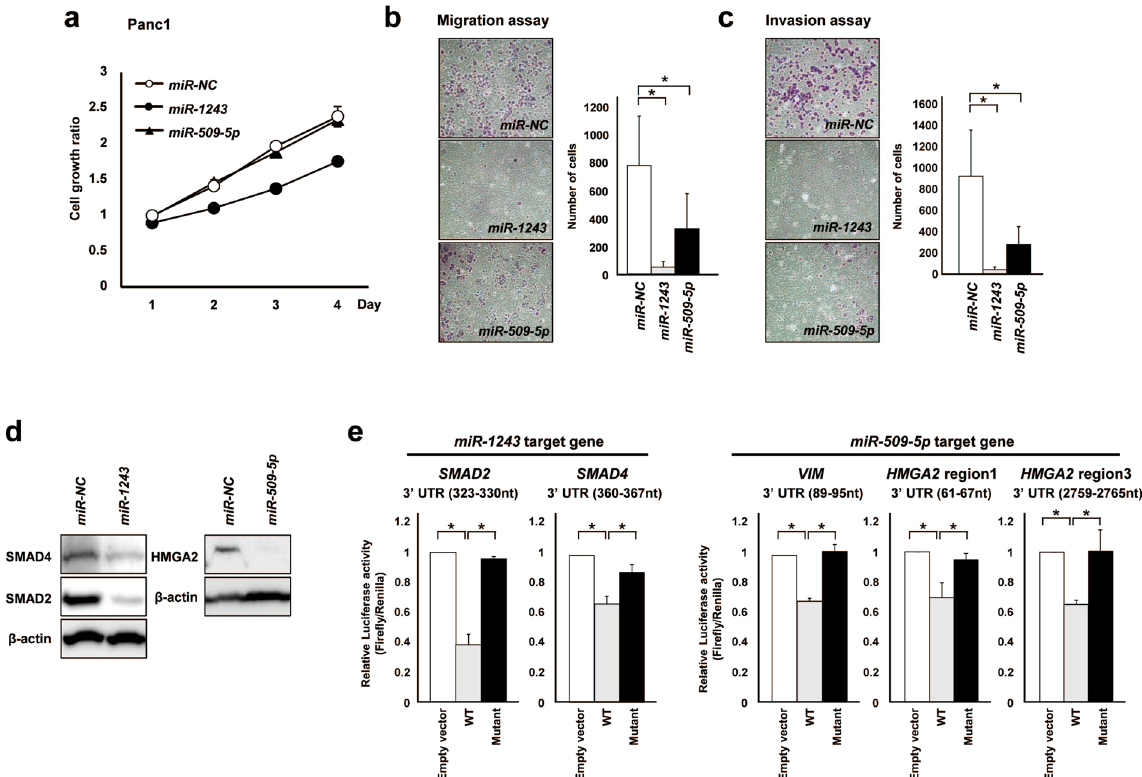
Figure 3. miR-509-5p and miR-1243 suppress cell motility and invasion through an MET phenotype alteration and directly target VIM , HMGA2 , SMAD2 and SMAD4 . ( a ) The number of viable cells 24–96 hours after transfection with 5 nmol/L of miR-NC , miR-509-5p and miR-1243 in Panc1 cells was assessed by the WST-8 assay. Each data point represents the mean of triplicate experiments (bars, SD). ( b , c ) Transwell migration and invasion assays were performed in 24-well modified Boyden chambers without and with Matrigel, respectively. Panc1 cells (4 × 10 4 cells per well [migration and invasion assay]) that were transfected with each miRNA were transferred into the upper chamber, and the migrated or invaded cells on the lower surface of the filters were fixed, stained and counted after 24 hours of incubation. Experiments were performed in triplicate, and each data point represents the mean (bars, SD). ( d ) Western blot analysis of SMAD2, SMAD4 and HMGA2 in Panc1 cells 72 hours after transfection with 10 nmol/L of miR-NC , miR-509-5p and miR-1243 . ( e ) Results of the luciferase reporter assays in Panc1 cells after co-transfection of the pmirGLO Dual-Luciferase vectors containing wild- type (WT) of SMAD2 , SMAD4 , VIM and HMGA2 or mutant variants of these genes and miR-NC , miR-509-5p and miR-1243 . Student’s t -test was used for statistical analysis, and asterisks represent P < 0.05 versus miR-NC